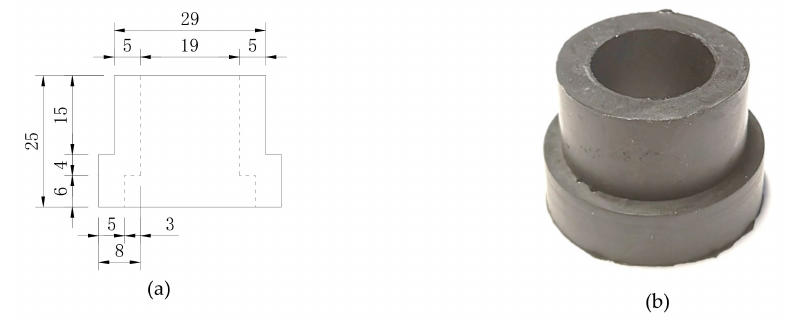
Figure 4. Rubber sleeve: ( a ) details (mm); ( b ) photo.